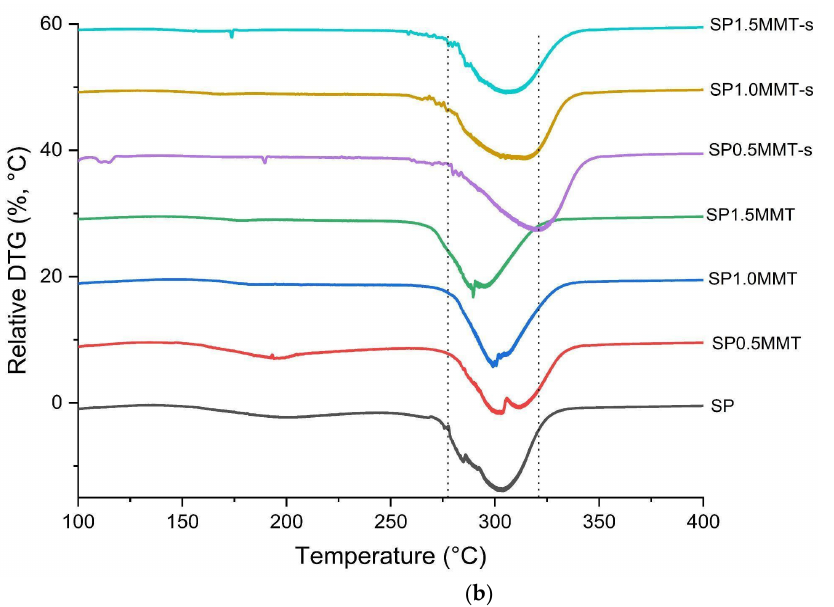
Figure 6. Thermogravimetric Analysis (TGA) ( a ) and Derivative Thermogravimetry (DTG) ( b ) curves of bionanocomposite films at different concentrations of clay and ultrasound treatment. Table 2. Weight losses of 10% (T 10 ), initial degradation (T i ), maximum degradation (T d ), final degradation (T f ), glass transition (T g ) and melting (T m ) temperatures, results based on the obtained TGA and DSC thermograms for the